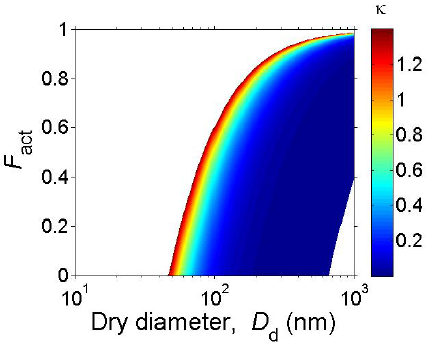
Figure 3. The activation fraction F act measured by a BS2-CCNC as a function of particle dry diameter D d and κ . The S tube profile of the BS2-CCNC is taken the same as in Fig. 2b.